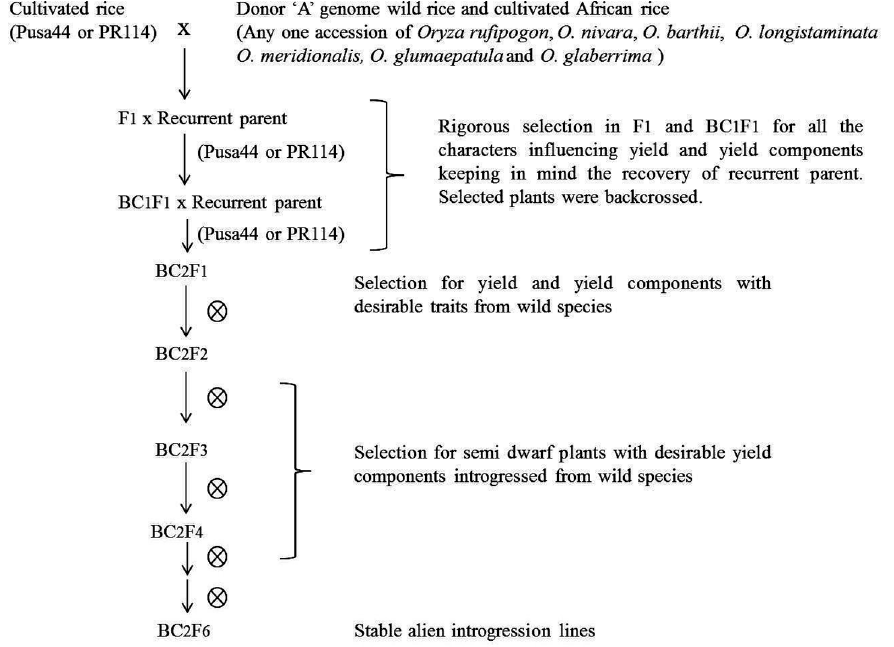
Figure 1. Development of alien introgression lines.